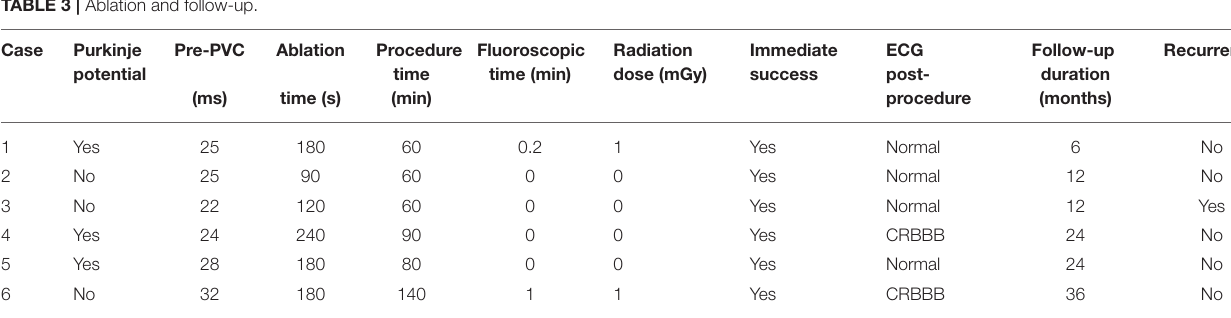
TABLE 3 | Ablation and